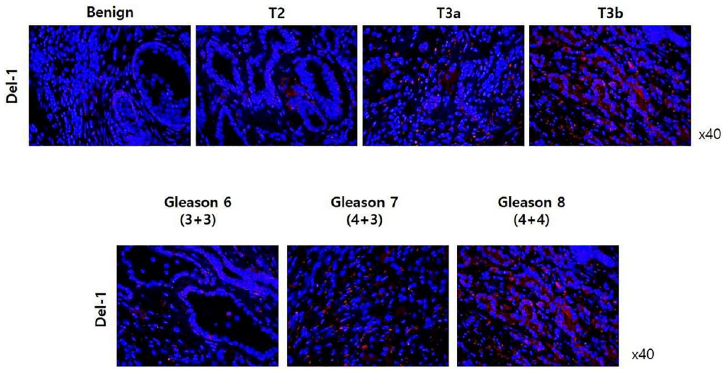
Fig 5. Immunohistochemistry results in in benign prostate tissue and prostate adenocarcinoma according to pT stage and Gleason score.